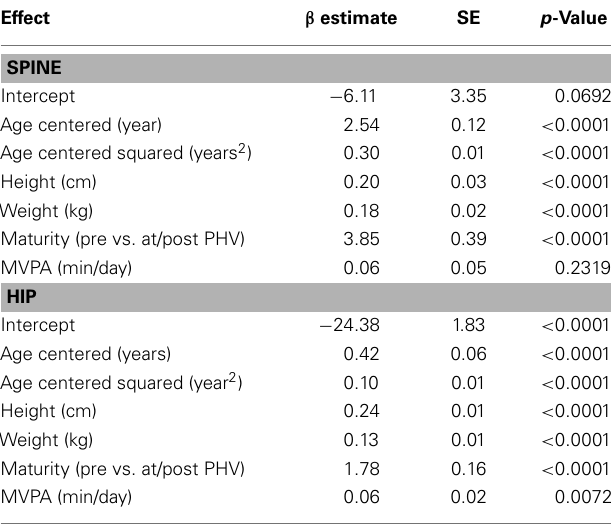
Table 3 | Fixed-effects of the multi-level models examining the association of MVPA with spine and hip BMC in females